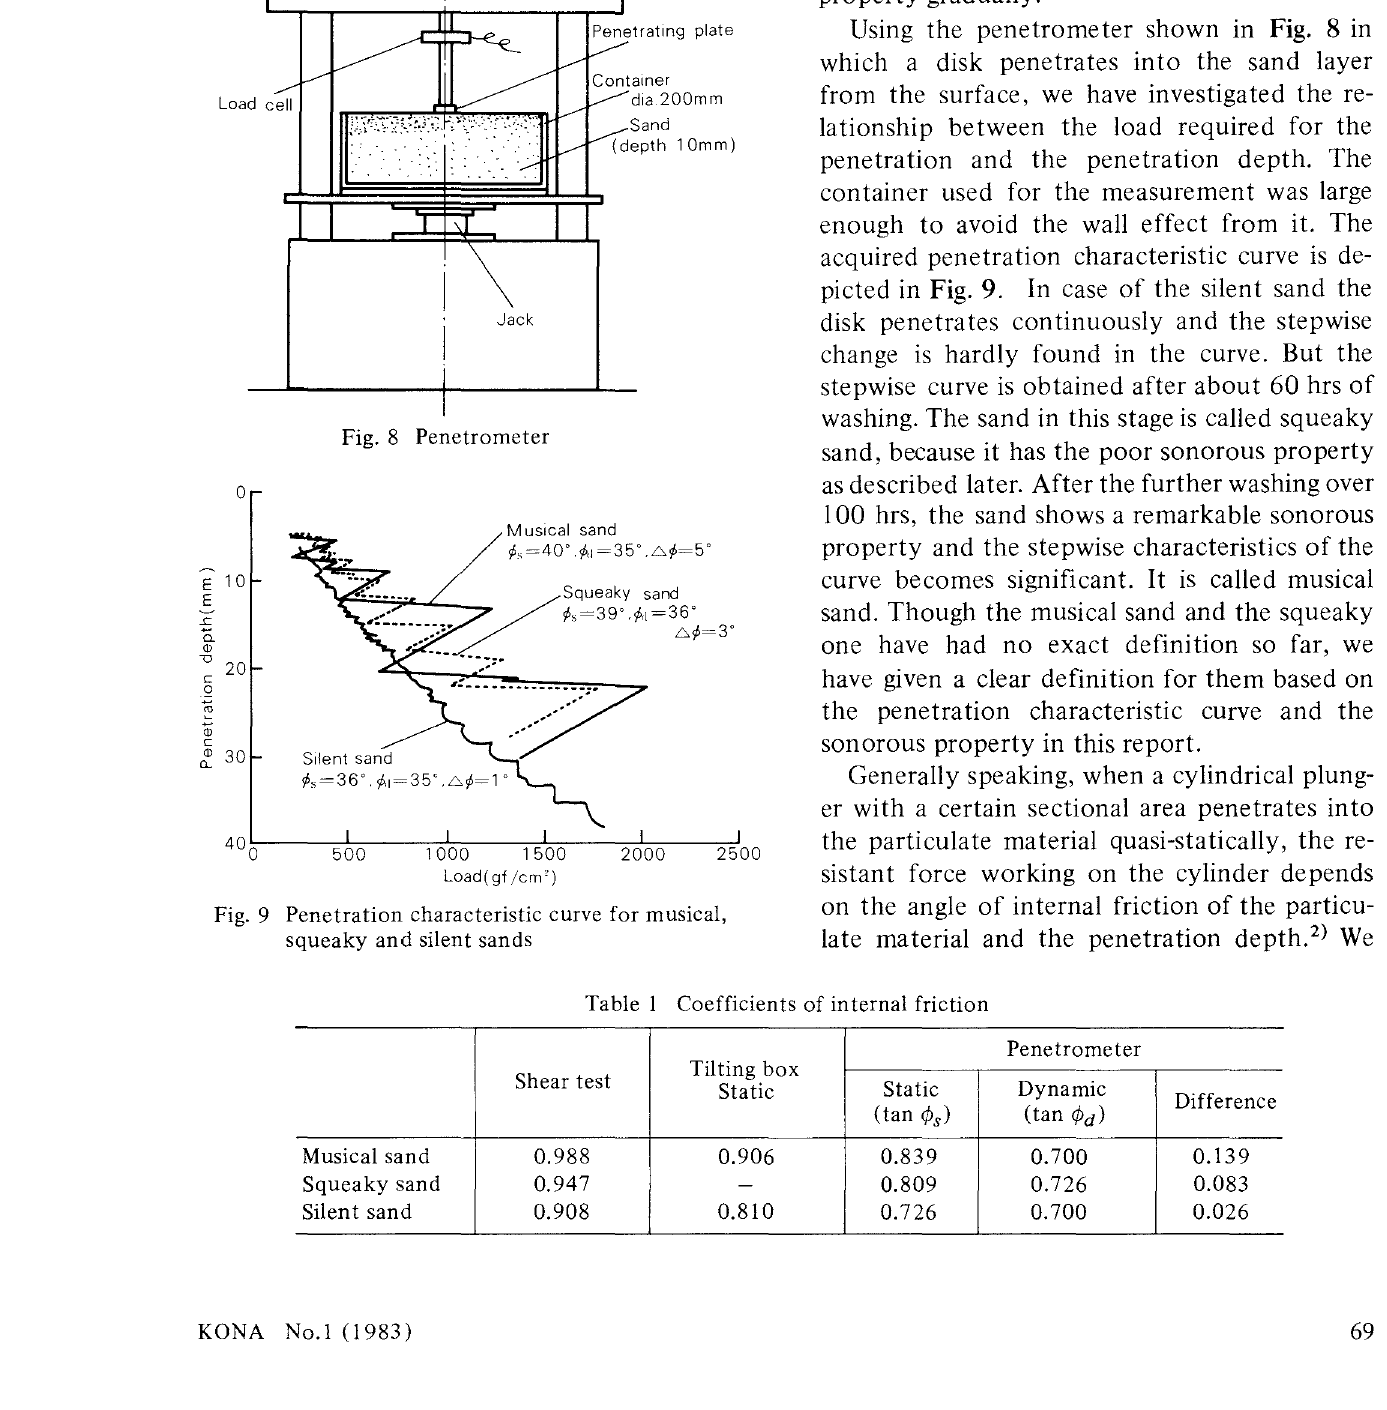
Fig. 8 Penetrometer